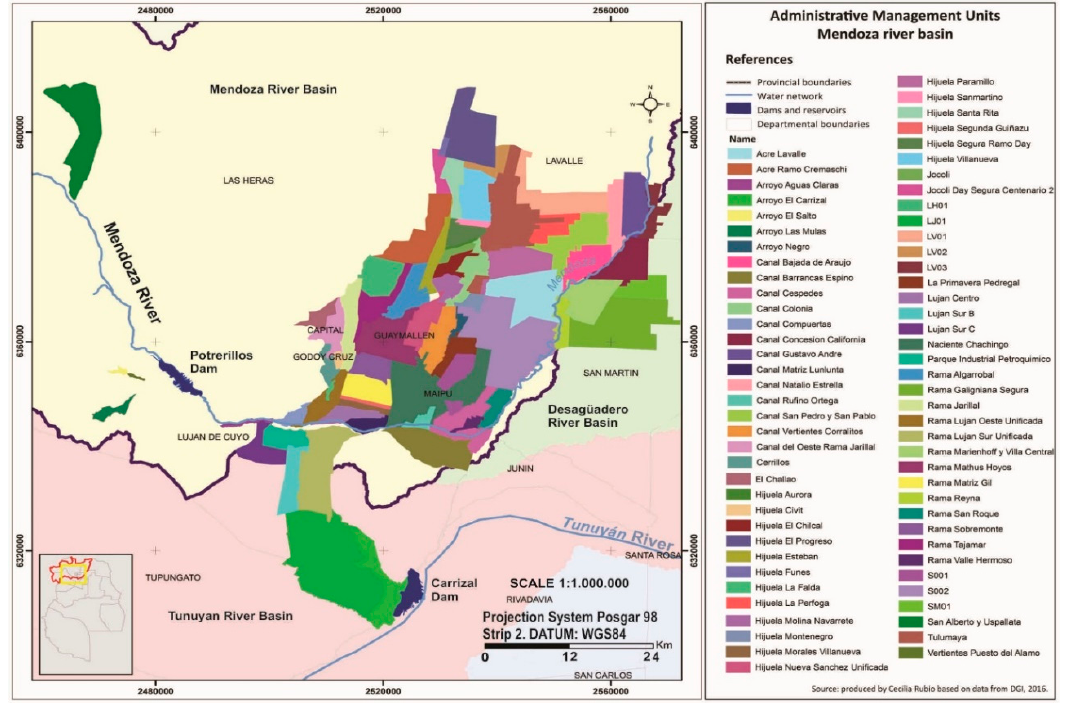
Table 2. Water rights to irrigation water use and efficiencies. Mendoza River basin.